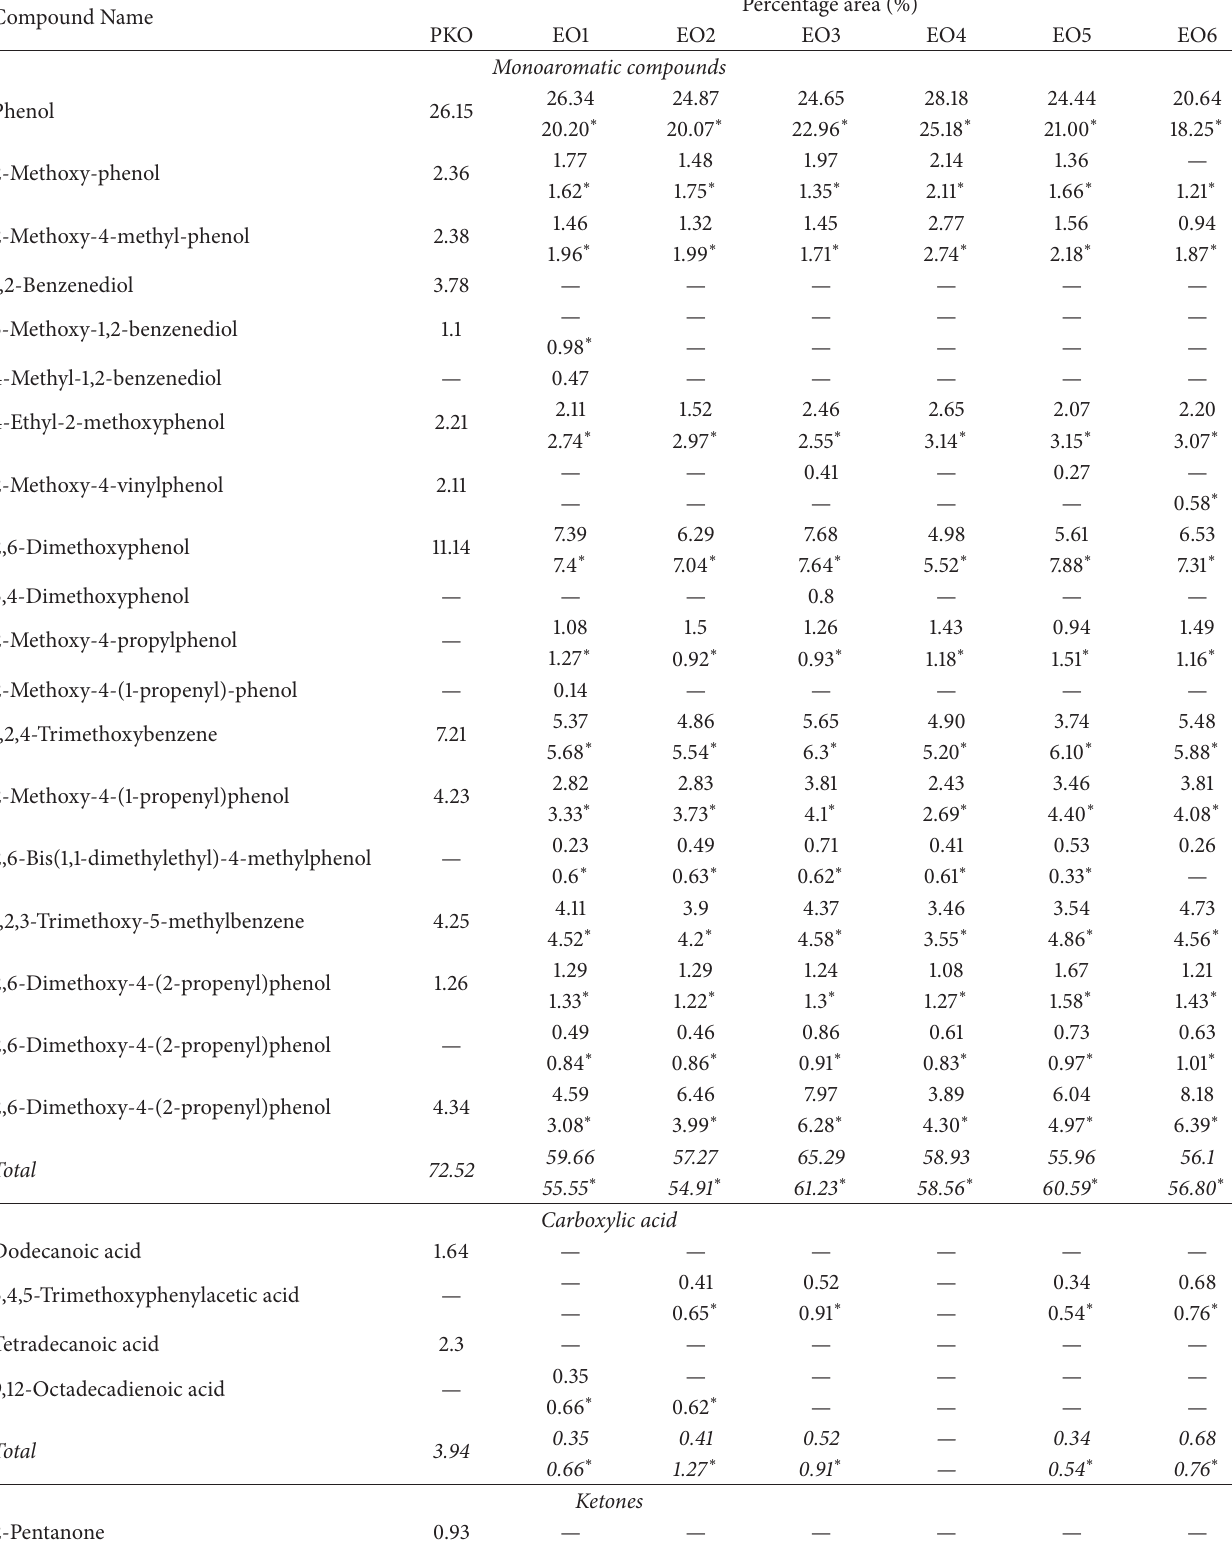
Table 2: Chemical composition of PKO and EO (not marked: concentrated at 35 ∘ C; marked ( ∗ ): concentrated at 78 ∘ C). Compound